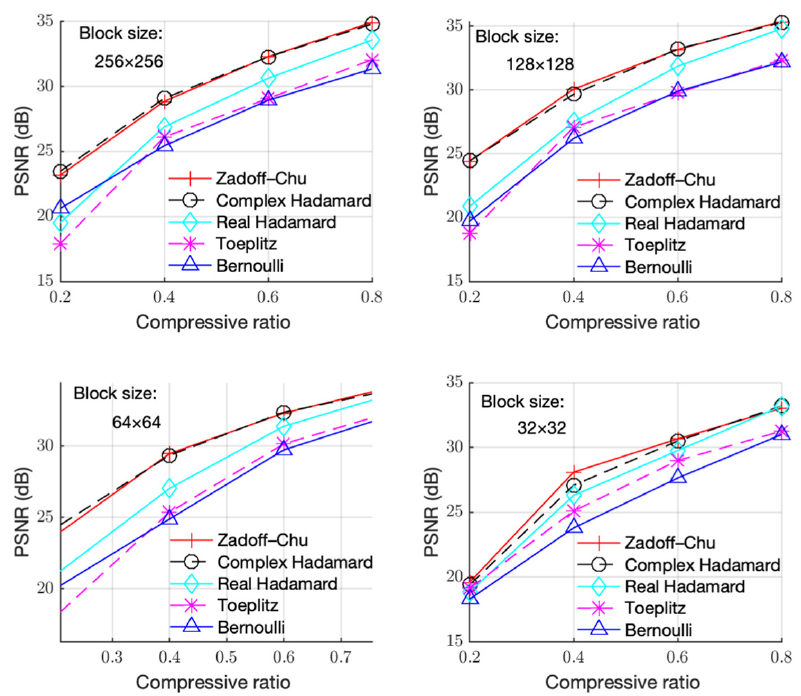
Figure 4. PSNR with CR under different block sizes for the “Foreman” image.